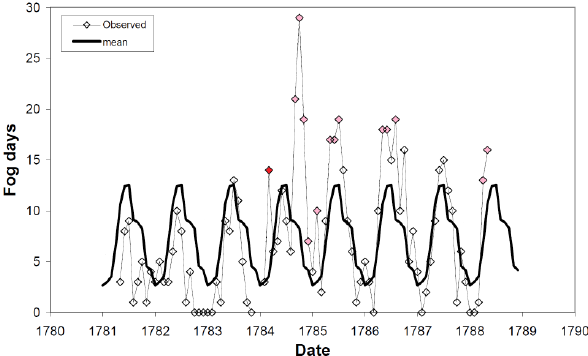
Figure 11. Monthly values of number of fog days (nfd) recorded by Dorta Fig. 11. Monthly values of number of fog days (nfd) recorded by between 1781 and 1788 compared with the corresponding average (bold line). The outstanding values that lie above the corresponding 1 σ (2 σ ) values were Dorta between 1781 and 1788 compared with the corresponding filled with pink (red) color. average (bold line). The outstanding values that lie above the corre- sponding 1 σ (2 σ ) values were filled with pink (red)